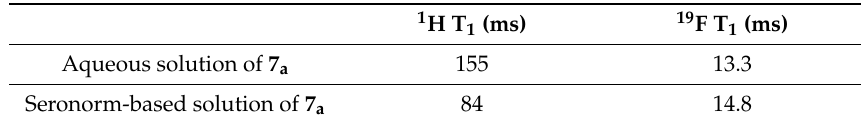
Table 3. Proton and fluorine T 1 relaxation times for aqueous and Seronorm-based solutions of complex 7 a at a concentration of 1 mM. The proton relaxation times were measured at 20 MHz and 37 ◦ C, whereas the fluorine relaxation times were measured at 500 MHz and 37 ◦